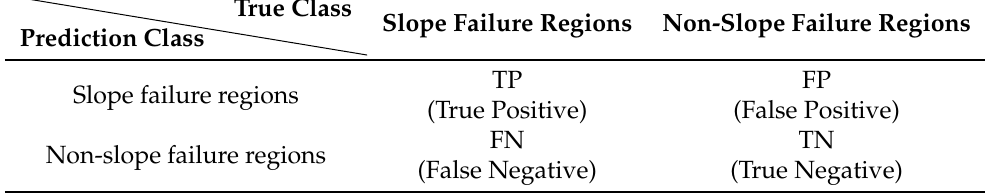
Table 3. Confusion